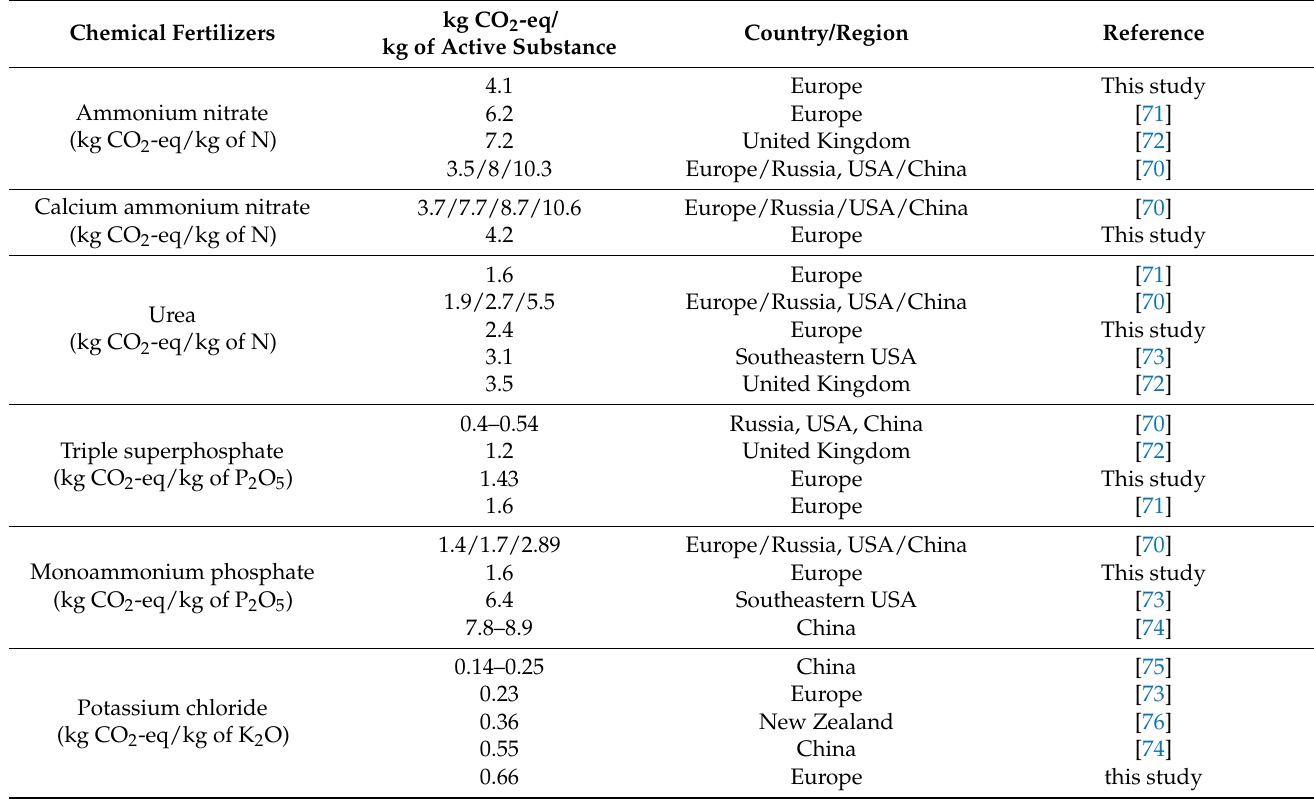
Table 13. Global warming potential (kg CO 2 -eq) values generated by the production of different chemical fertilizers. kg CO 2 Chemical Fertilizers